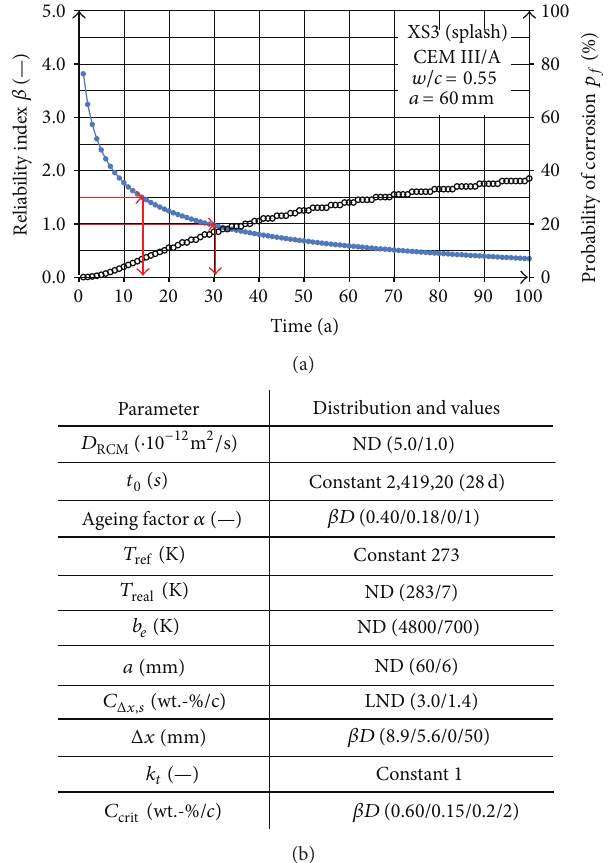
Figure 1: Development of reliability index and probability of corrosion over time of a marine structural element (a) with the input parameters